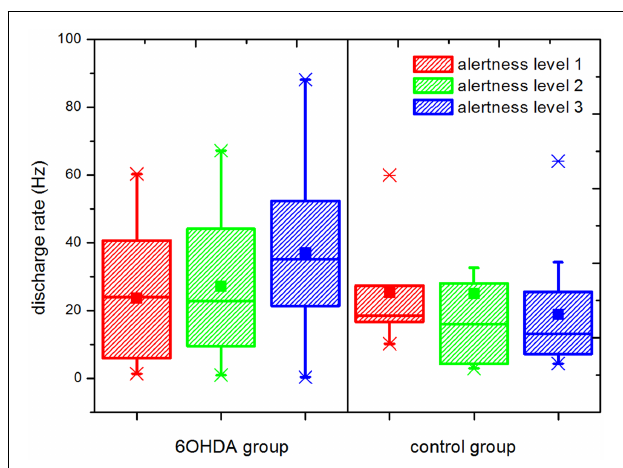
FIGURE 4 | Rate of discharge at different levels of alertness . An increment in the discharge rate is observed in the parkinsonian neurons following increasing levels of alertness. A statistically significant difference was observed between the parkinsonian ( n = 17) and control ( n = 21) neurons at alertness level 3 ( p ≤ 0.05), showing that this difference depends on the input received by the basal ganglia network. Upper and lower edges of the boxes represent percentile 75 (p75) and percentile 25 (p25) respectively, the inner line indicates the median, upper, and lower whiskers account for p75 + 1.5 (p75–p25) and p25–p1.5 (p75–p25), respectively.The mean is represented by the inner, solid box. Crosses indicate